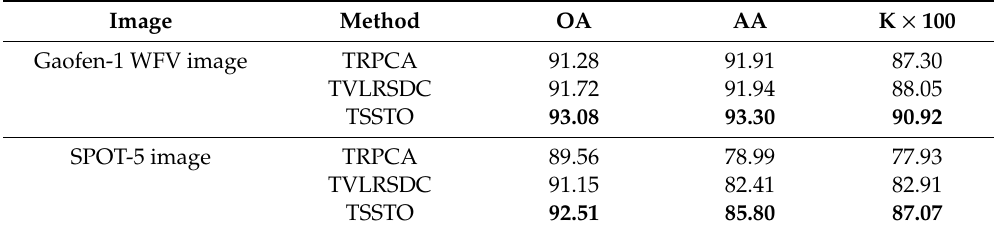
Figure 20. Cloud / shadow detection results for the real-data experiments. ( a ) Cloud image; ( b ) ground truth; ( c – e ) the detection results of TRPCA, TVLRSDC, and TSSTO, respectively. Table 7. The AA, OA, and Kappa in the real-data experiments. The bold values denote the highest accuracies in each experiment.